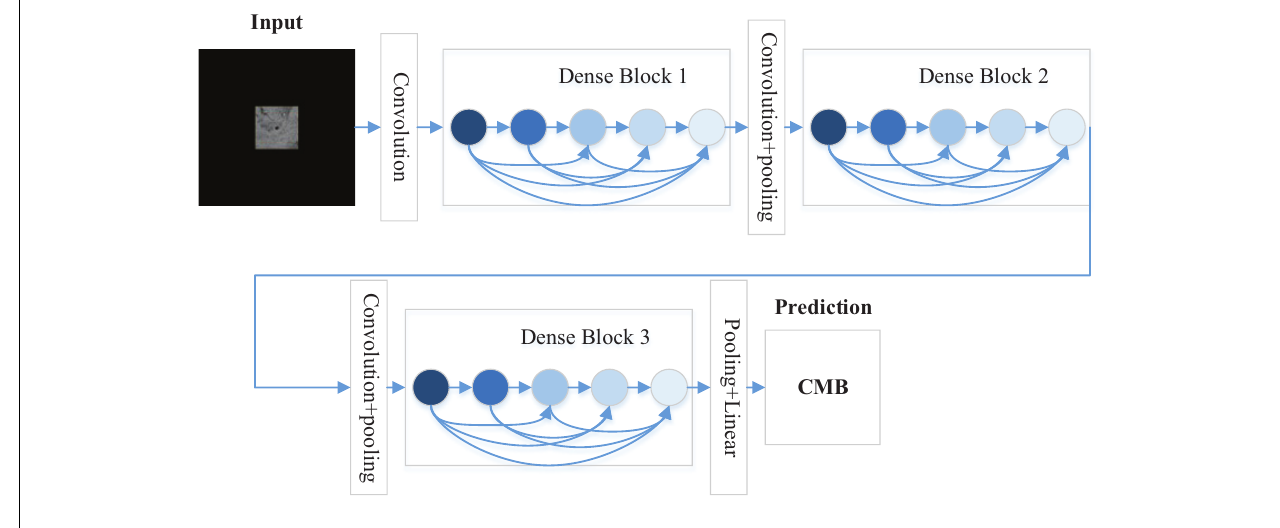
FIGURE 3 | The structure of the DenseNet.